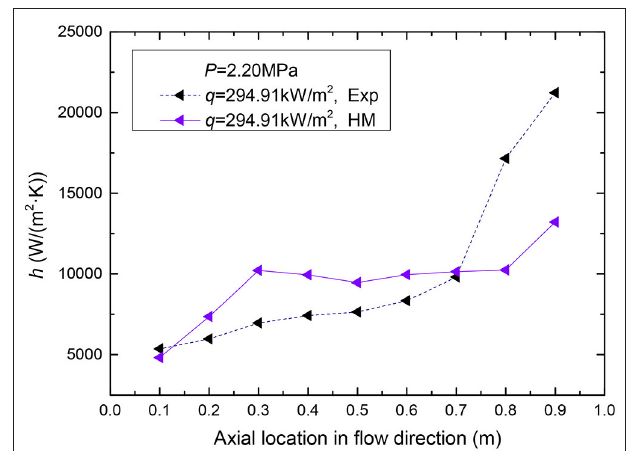
FIGURE 8 | The effects of the distribution parameters and the averaged drift velocities on the heat transfer coefficients.